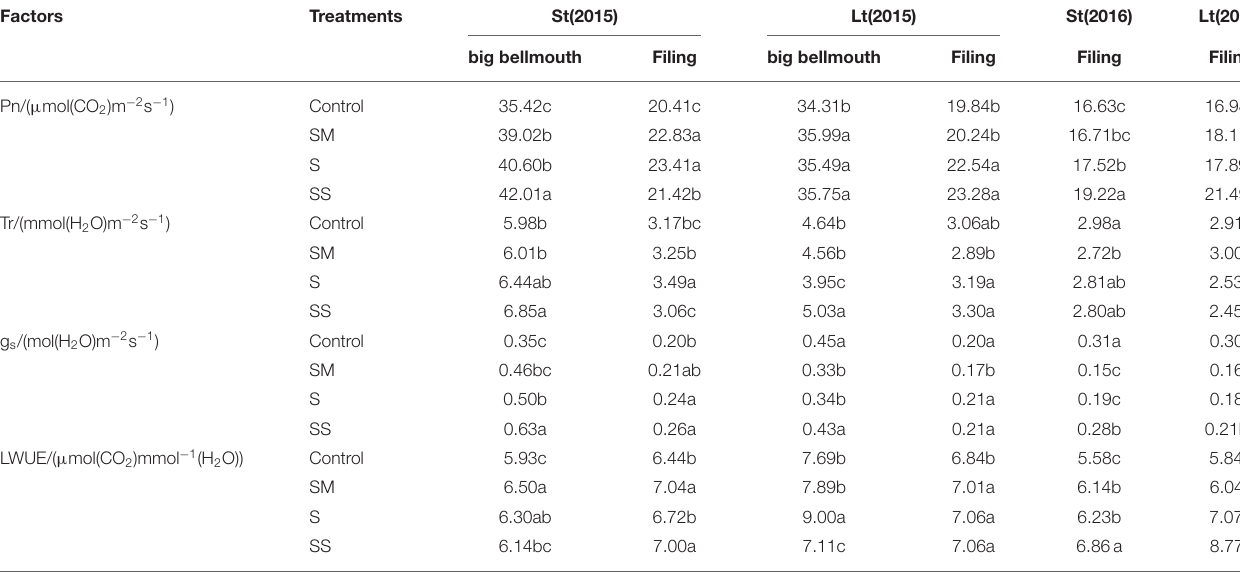
TABLE 3 | Photosynthetic characteristics in different growth stages of maize under the Control, SM, S and SS treatments in different years.